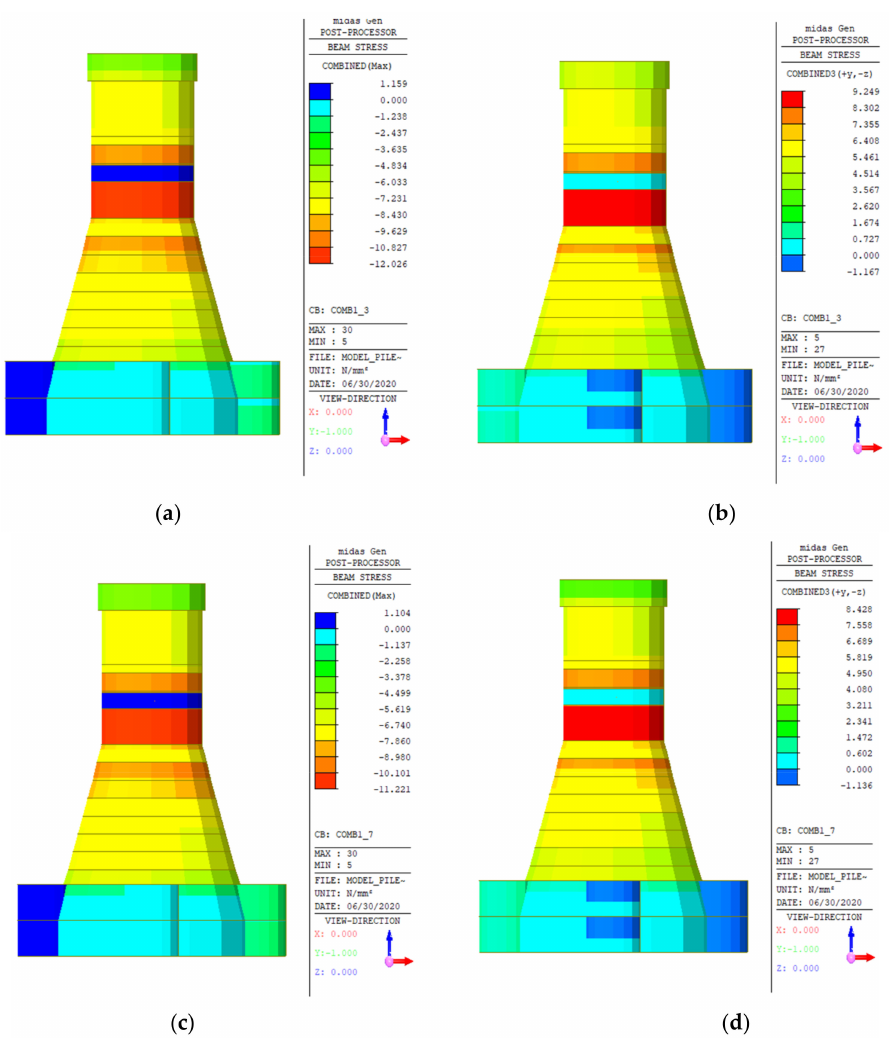
Figure 11. Stress distributions in the concrete parts (unit = MPa): ( a ) maximum compression in DLC6.2da; ( b ) maximum tension in DLC6.2da; ( c ) maximum compression in DLC6.2fd; and ( d ) maximum tension in